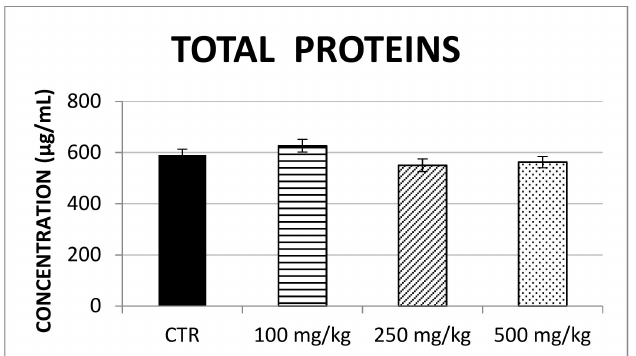
Figure 3. The concentration of soluble liver proteins calculated using the BCA assay is reported in control and treated groups. CTR = control.